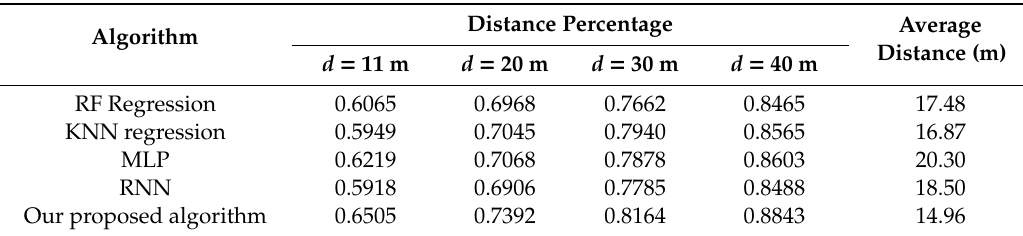
Table 6. The distance percentage and average distance of di ff erent predication algorithms for the testing